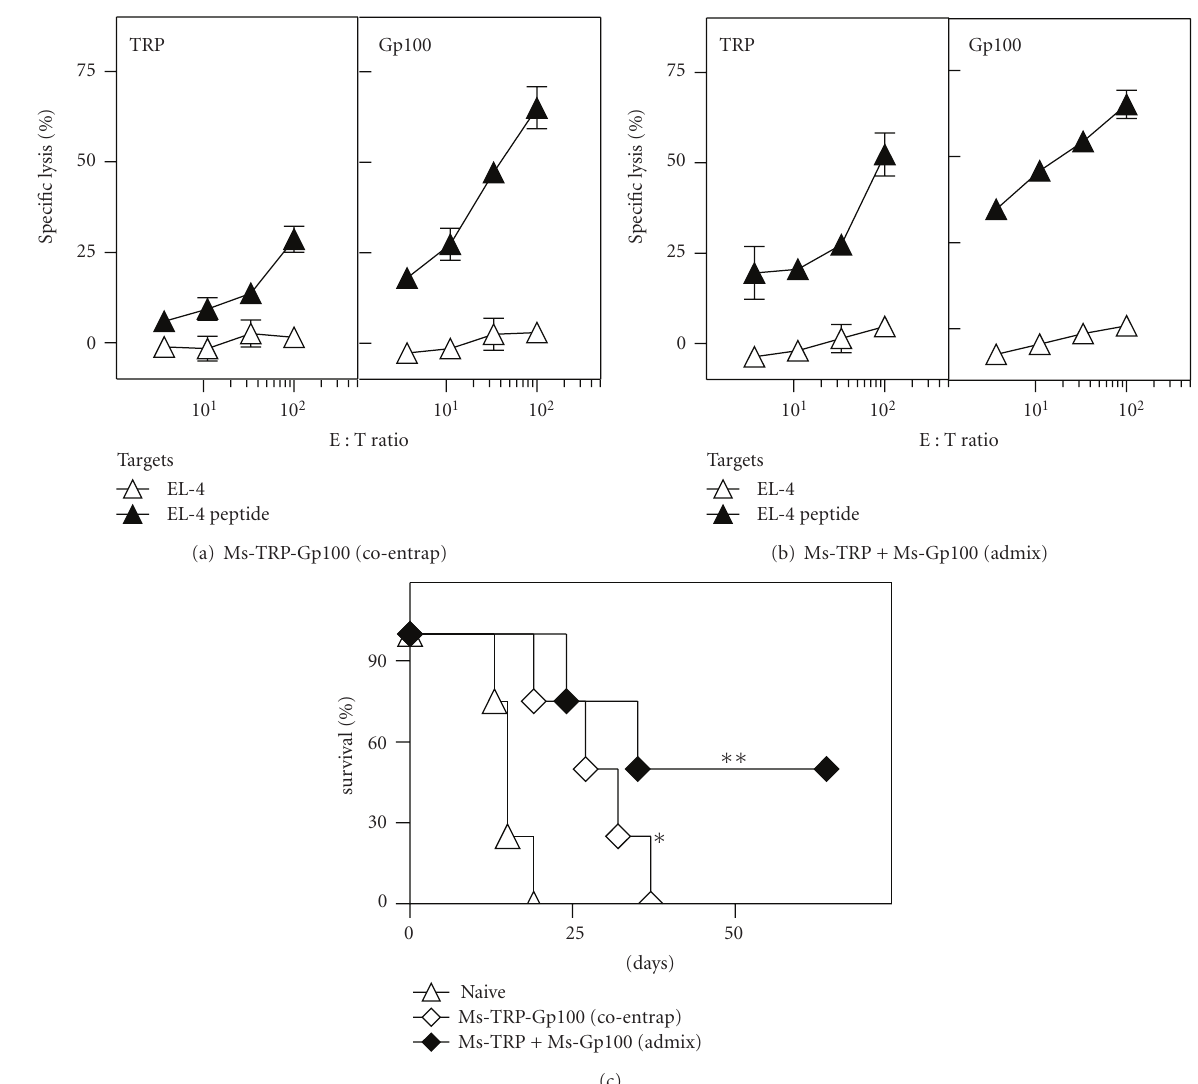
Figure 5: CD8 + T cell response and tumor protection induced by coentrapped melanoma peptide-archaeosome vaccine. Mice were vaccinated (days 0 and 21) with 25 μ g of peptides (coentrapped 5 μ g TRP and 20 μ g Gp100) or an equivalent admixed formulation of Ms-TRP and Ms-Gp100. In vitro CTL response of spleen e ff ectors from representative mice ( n = 2) was evaluated at 5 weeks (a, b) on TRP and Gp100 specific targets. Mean ± SD of triplicate cultures of e ff ectors: targets at various ratios are indicated. At 6 weeks mice were challenged subcutaneously with B16 melanoma, and survival ( n = 4/group) was evaluated based on a maximum tumor size of 300mm 2 (c). Loadings were 13 μ g Gp100 and 3 μ g TRP/mg archaeosomes for the coentrapped vaccine used in (a, c), and 60 μ g Gp100/mg lipid and 30 μ g TRP/mg archaeosomes for the admixed used in (b, c). Archaeosome size ranged from 104 to 110nm. Survival for the vaccinated groups was significantly di ff erent compared to na¨ıve animals by log-rank test ( ∗ P < . 05; ∗∗ P < .